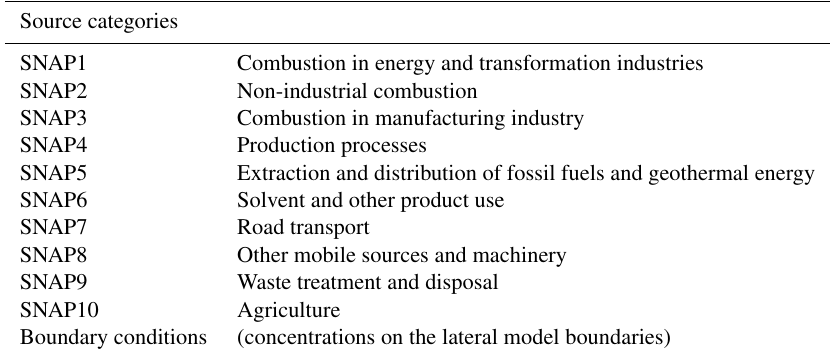
Table 1. Source categories used in this